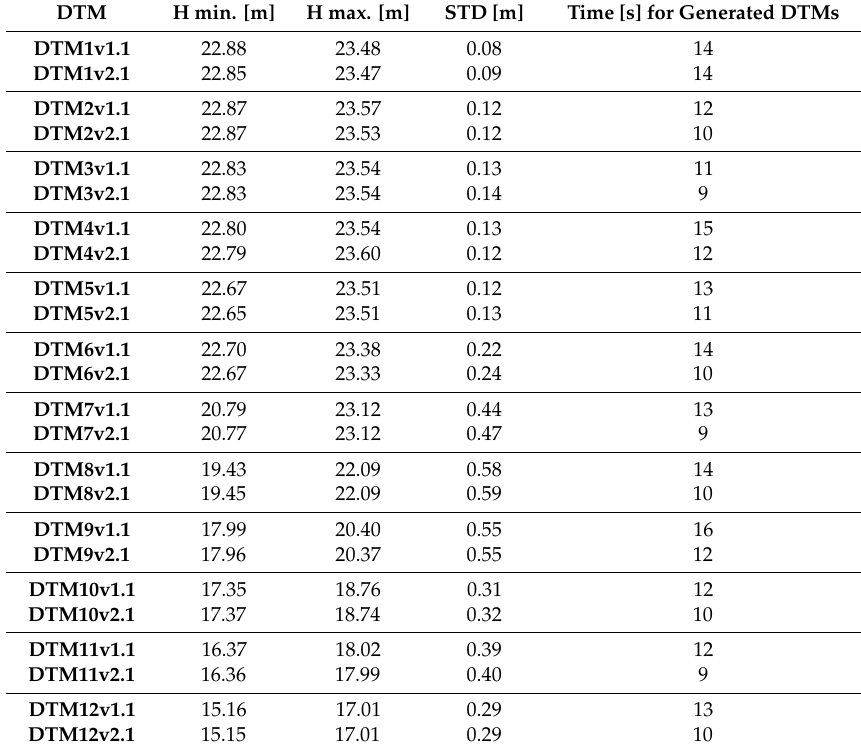
Figure 11. Isolines3v1.1 and DTM3v1.1, and isolines3v2.1 and DTM3v2.1 generated for strip 3 (p 3 ) by methodologies v1.1 and v2.1, respectively. Table 3. StatisticalcharacteristicsforDTMmv1.1andDTMmv2.1. (Where: